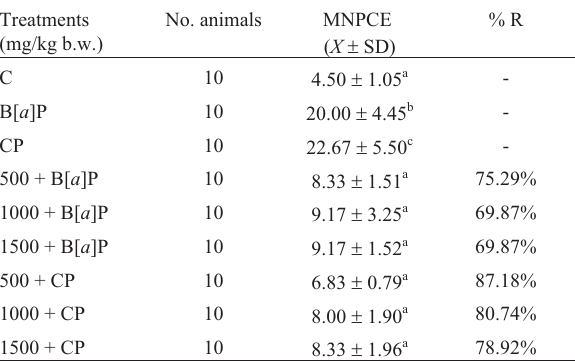
Table 1 - Numbers of micronucleated PCEs (MNPCE) from mouse bone marrowandpercentdamagereduction(%R)obtainedinthedetermination of in vivo antimutagenicity of Spondias dulcis Forst F. bark ethanolic ex- tract at three concentrations, and the respective controls. Treatments (mg/kg